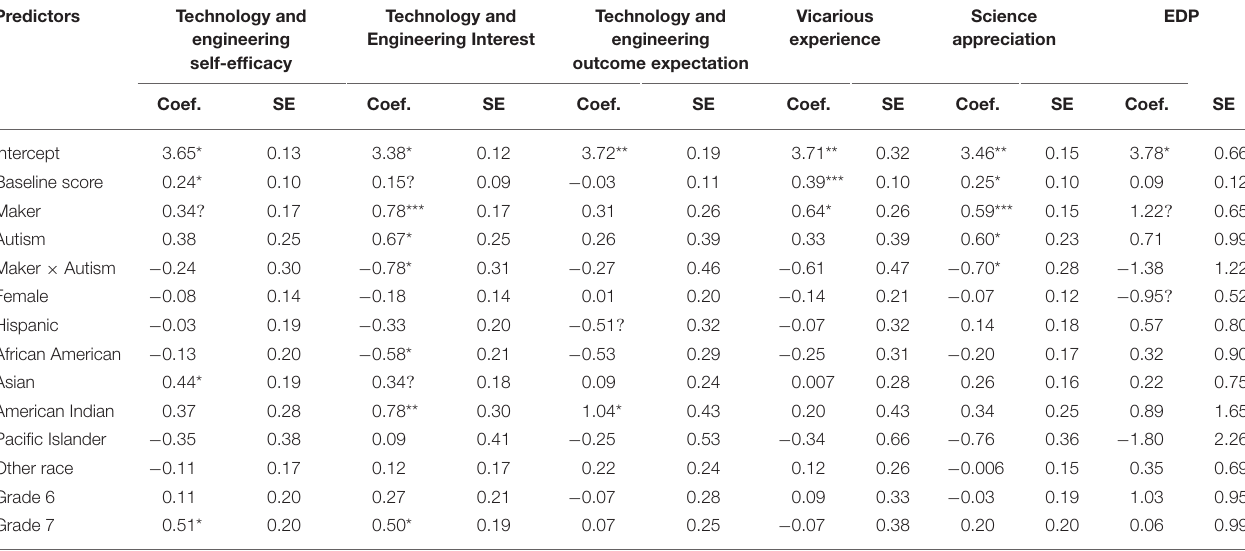
TABLE 3 | Summary of HLM of the effects of maker program on student outcomes.